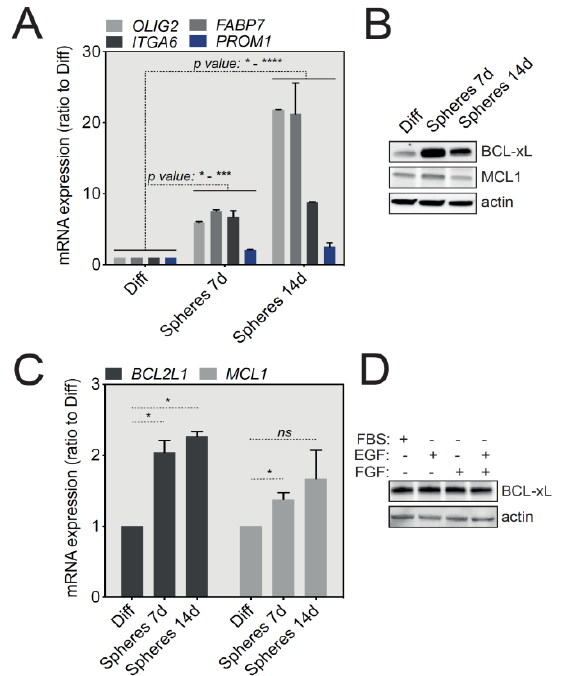
Figure 2. BCL-xL is highly expressed in U-87 MG-derived tumorspheres compared to differentiated cells. ( A ) qRT-PCR analysis of selected GSCs signature markers (OLIG2, ITGA6, FABP7, PROM1)